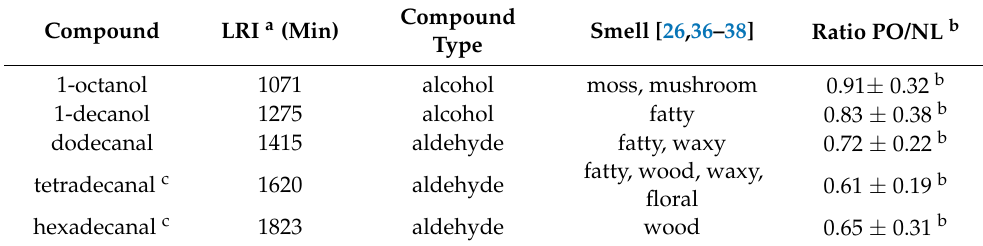
Table 2. Volatile Organic Compounds more abundant in Clemenules (NL) than in Clemenpons (PO). Compound Smell [26,36–38] Ratio PO/NL b Compound LRI a (Min) Type 1-octanol 1071 alcohol moss, mushroom 0.91 ± 0.32 b 1-decanol 1275 alcohol fatty 0.83 ± 0.38 b dodecanal 1415 aldehyde fatty, waxy 0.72 ± 0.22 b tetradecanal c